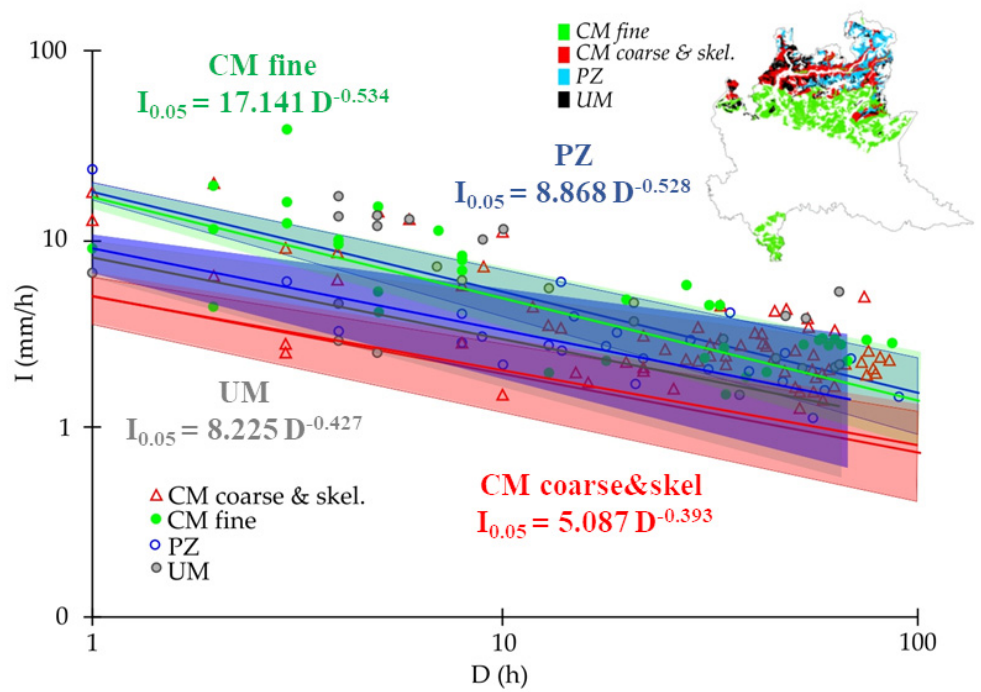
Figure 10. Rainfall intensity–rainfall duration (ID) thresholds for four different soil types: Cambisols fine soils (CM fine); Cambisols coarse and skeletal soils (CM coarse & skel.); Podzol soils (PZ); Umbrisol soils (UM). Colored lines are 5% power law thresholds. Shaded areas between dashed lines show the 95% confidence intervals of the threshold curves.